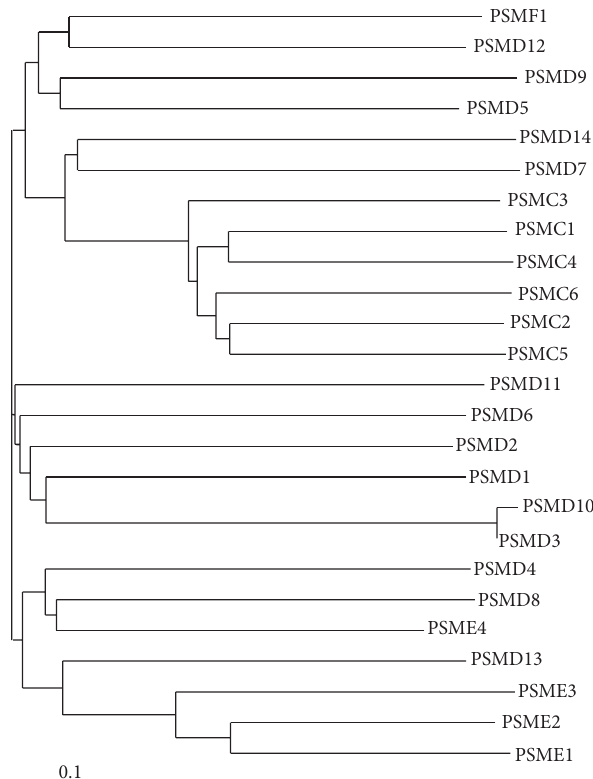
Figure 11: Phylogenetic tree of human PSMC, PSMD, PSME, and PSMF proteasome subunits. Phylogenetic tree was generated using Clustal W2 phylogeny [88] and image obtained using TreeView [89]. The UniProt accession numbers used for the alignment of proteasome subunits are given in Figures 9, 10, 12, and